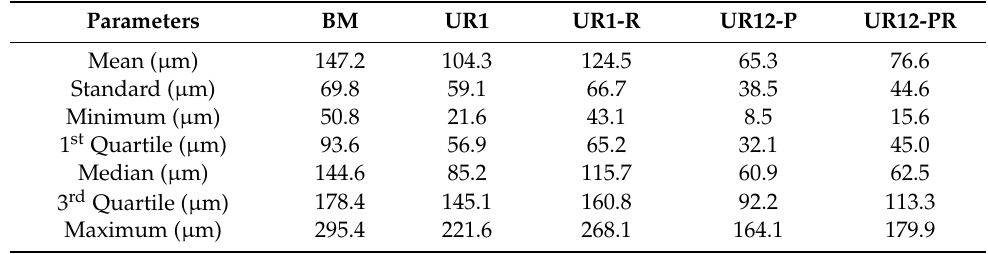
Table 3. Statistical parameters of corrosion depths for di ff erent samples.